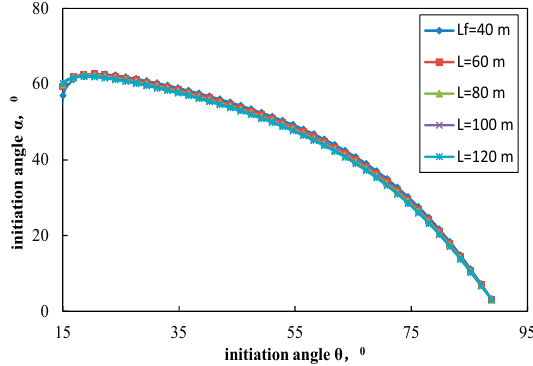
Figure 7. The impact of length of the fracture on the initiation angle.